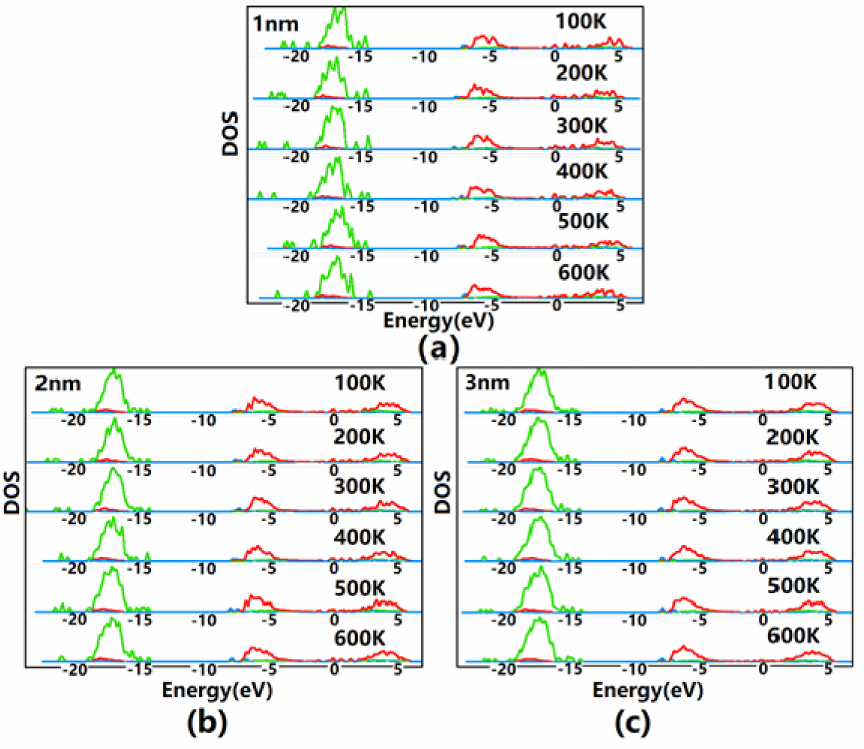
Figure 3. Projected density of states (PDOS) of the ITO films with thicknesses of 1 nm ( a ), 2 nm ( b ), and 3 nm ( c ) at temperatures varying from 100 to 600 K over Sn, O, and In atoms. PDOS over In, O, and Sn atoms are denoted by red, green, and blue colors.